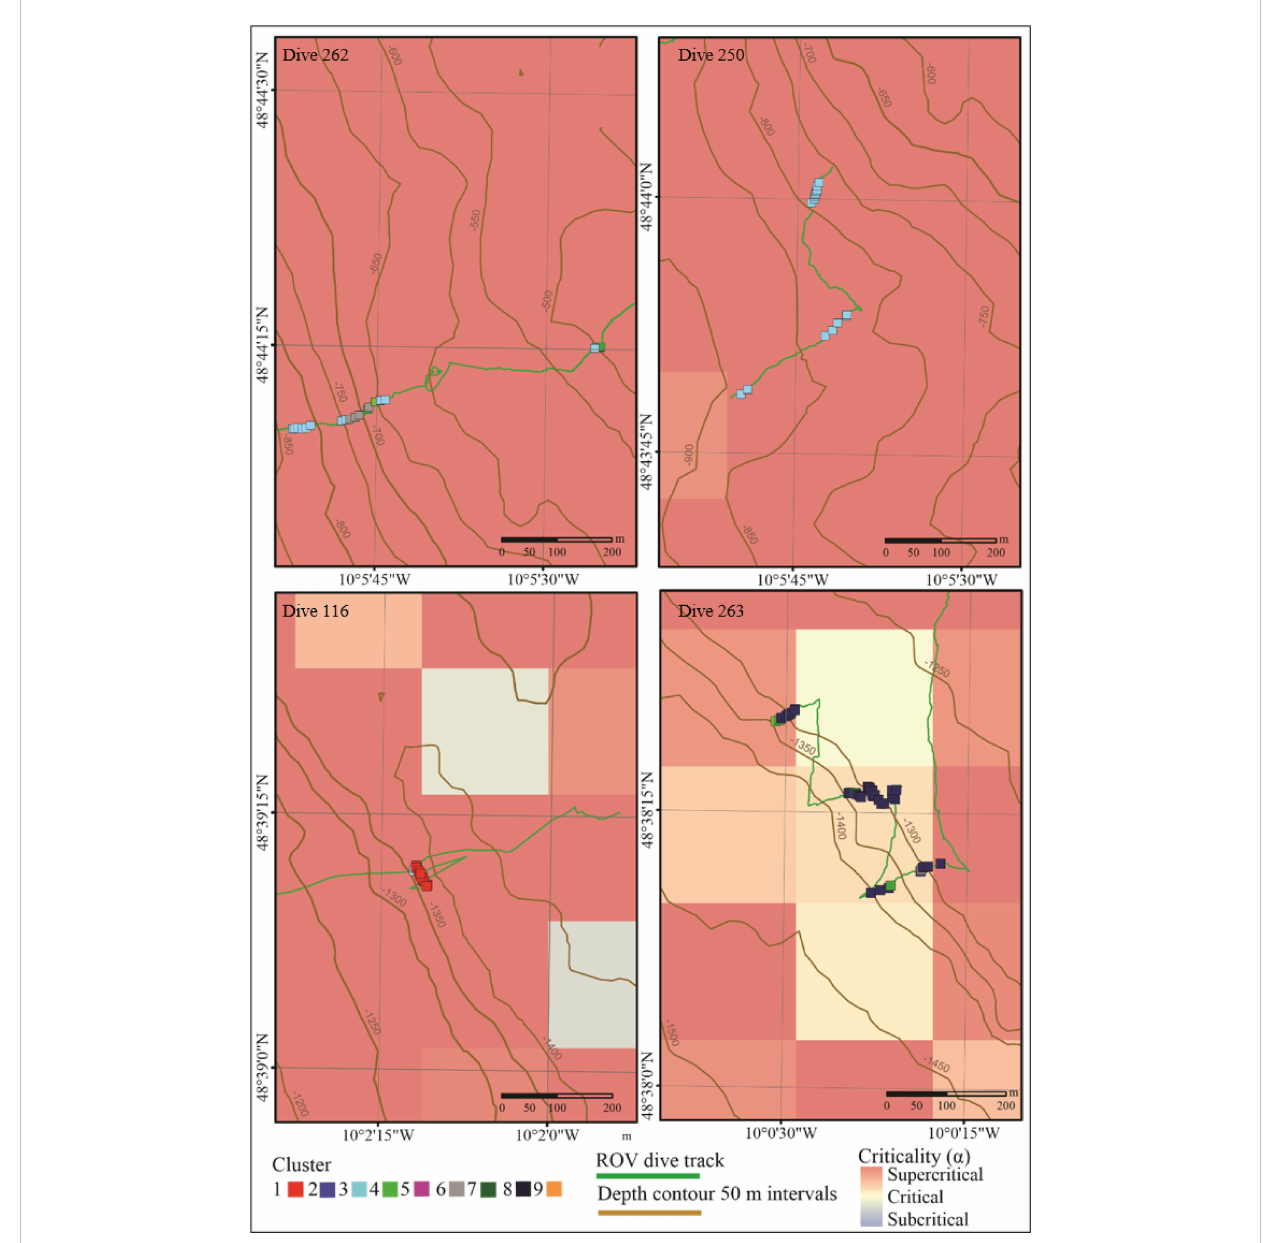
FIGURE 6 Spatial plot of sites (samples) from vertical walls across all dives plotted over bathymetric criticality to the M 2 tide. Samples are coloured to represent the nine clusters identi fi ed by hierarchal clustering